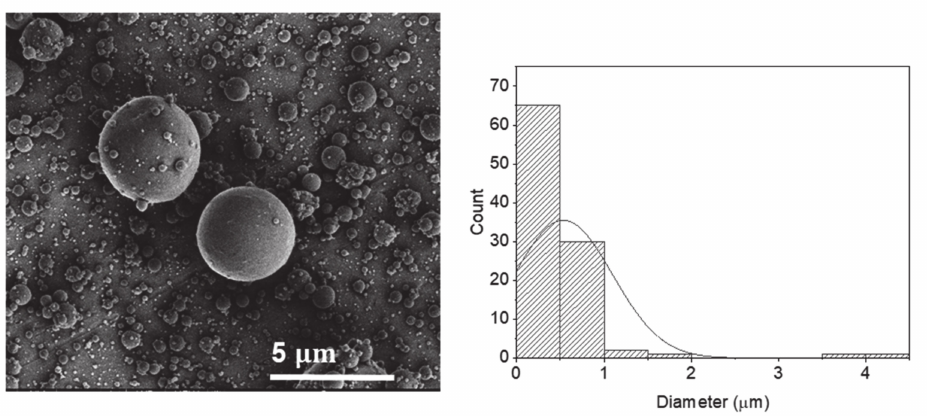
Figure 4. SEM images of electrosprayed potato protein particles and respective histograms displaying their diameter distribution using water:glycol (9:1) as